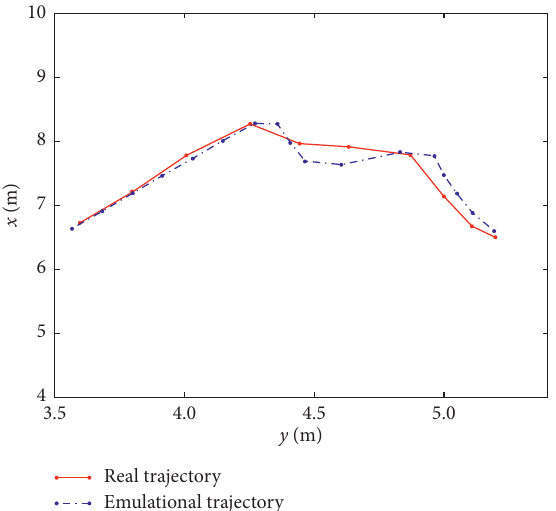
Figure 7: Comparison of passenger 6’s real and emulational